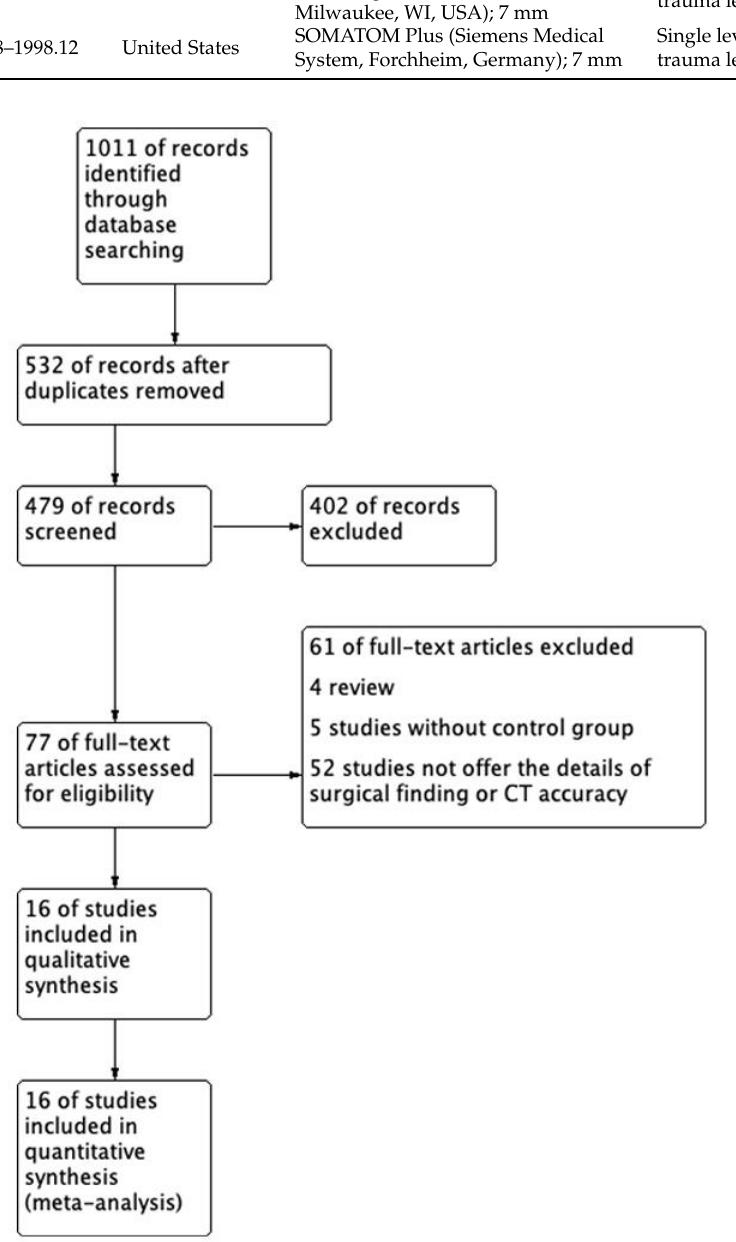
Figure 1. The flow diagram of this systematic review.